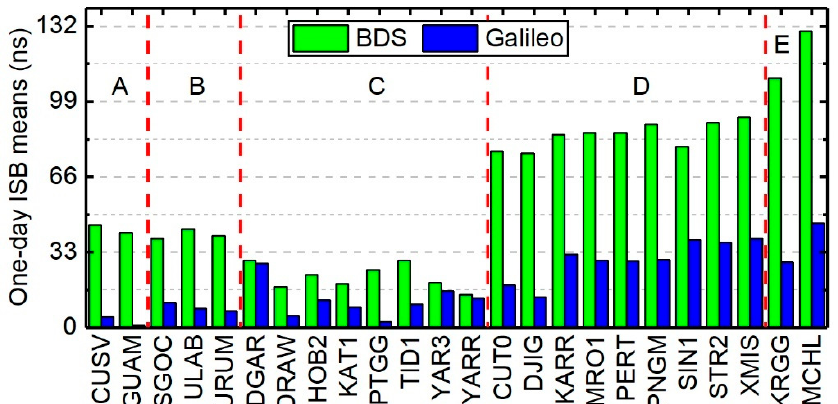
Figure 2. One day (3 September 2019) ISB means for BDS-2 and Galileo at the 24 stations. Stations with different receivers are separated by a red dashed line and are marked as “A” (JAVAD TRE_3 DELTA), “B” (JAVAD TRE_3), “C” (SEPT POLARX5), “D” (TRIMBLE NETR9), and “E” (TRIMBLE ALLOY).